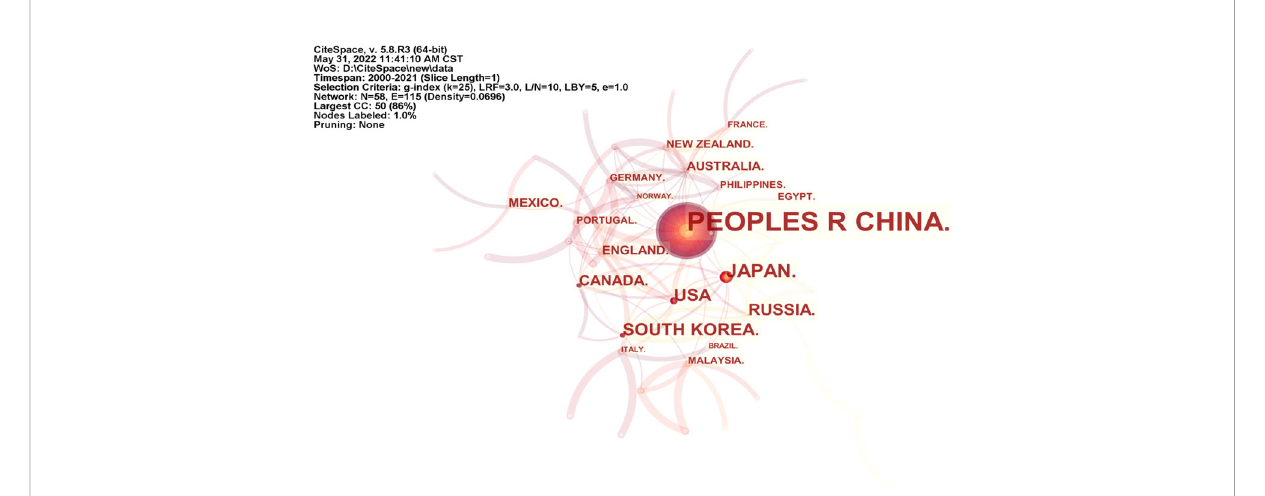
FIGURE 2 The map representing the international comparison of the number of Apostichopus japonicus literature and cooperative